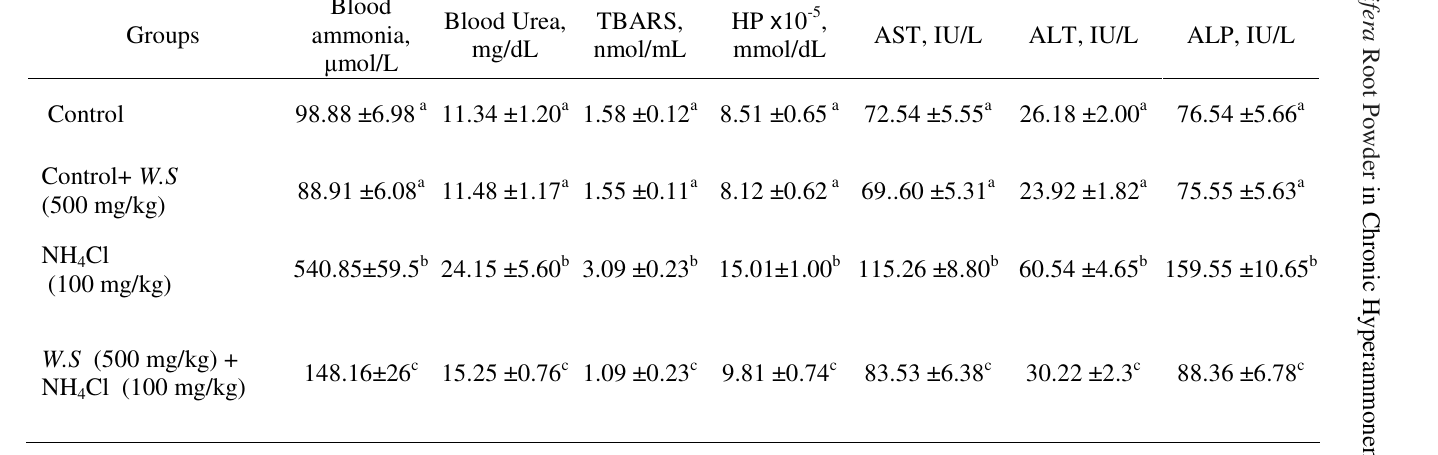
Data are presented as means ± SD of 8 rats in each group. The values with different superscript (a, b, c) are significant from each others, P<0.05 mean values are significantly different from the other groups (ANOVA followed by